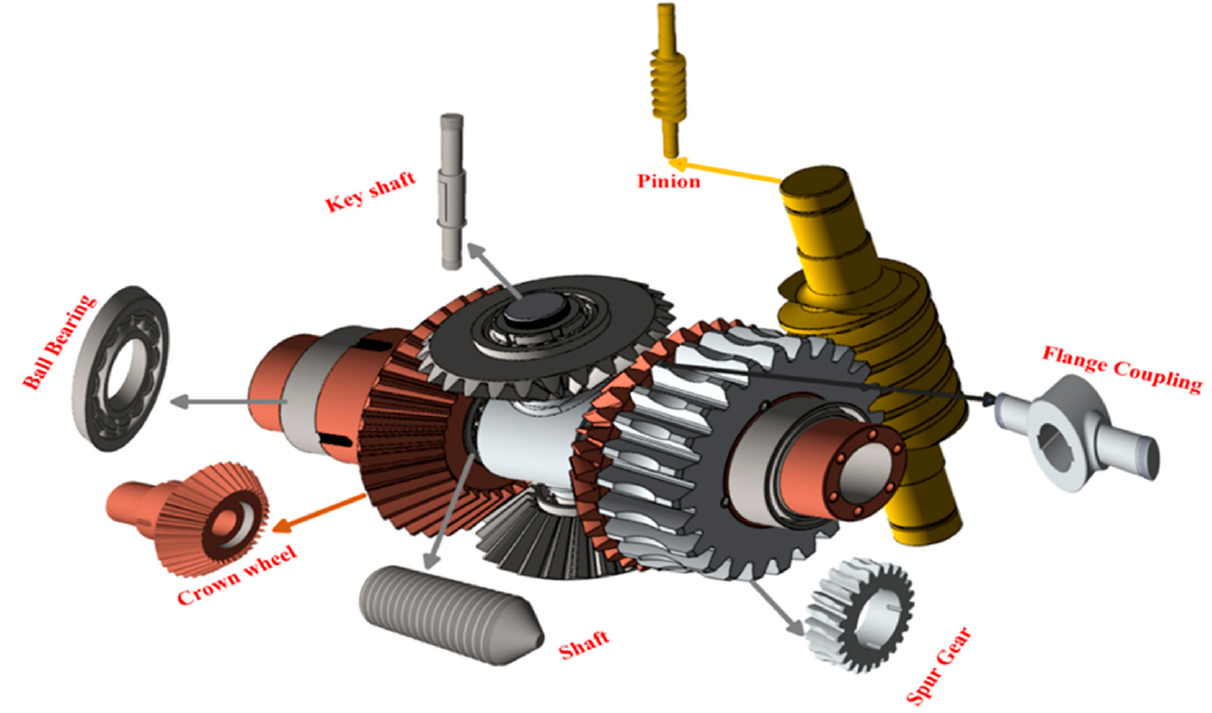
Figure 1. Various components in the gear box.